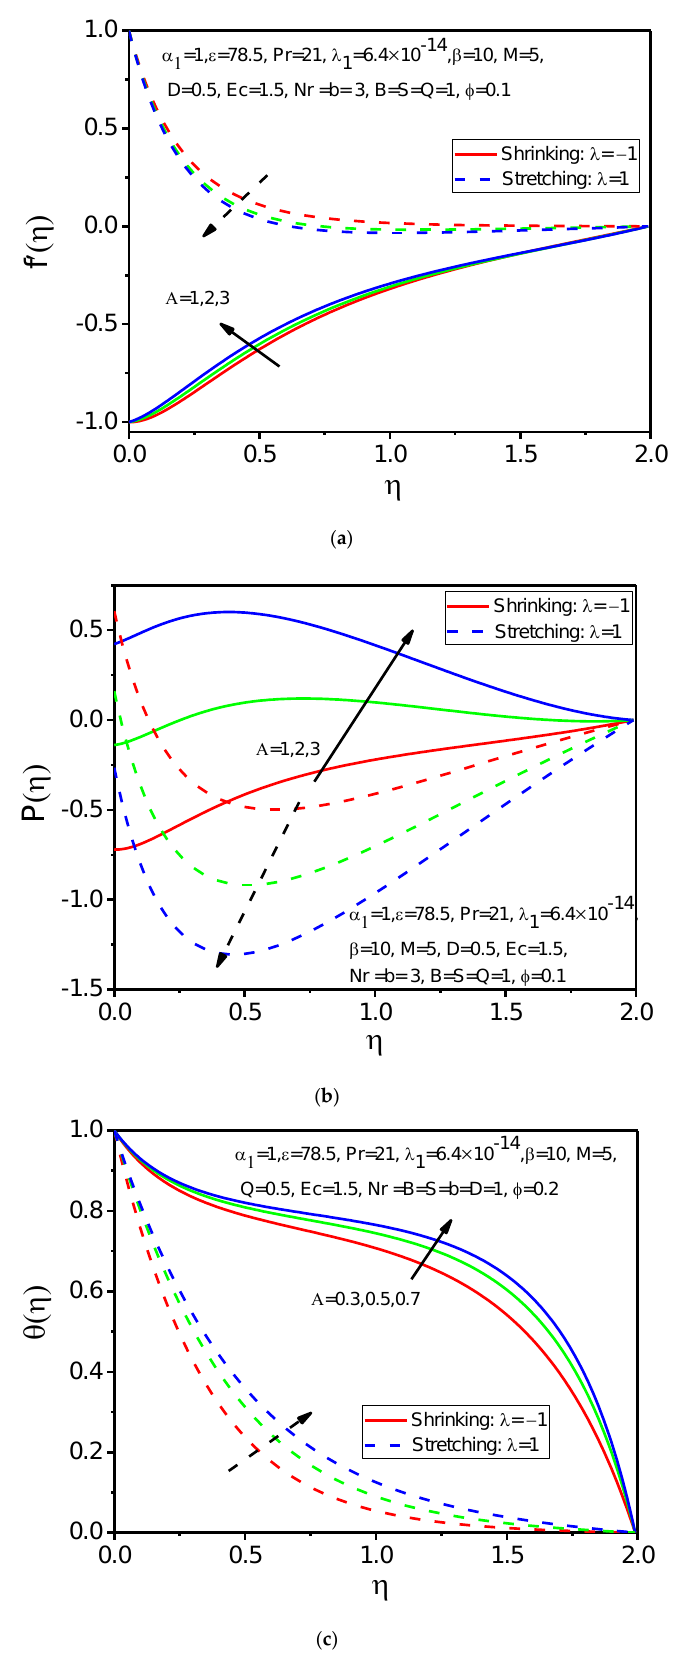
Figure 9. Variation of A on ( a ) Velocity profile, ( b ) Pressure profile, ( c ) Temperature profile.